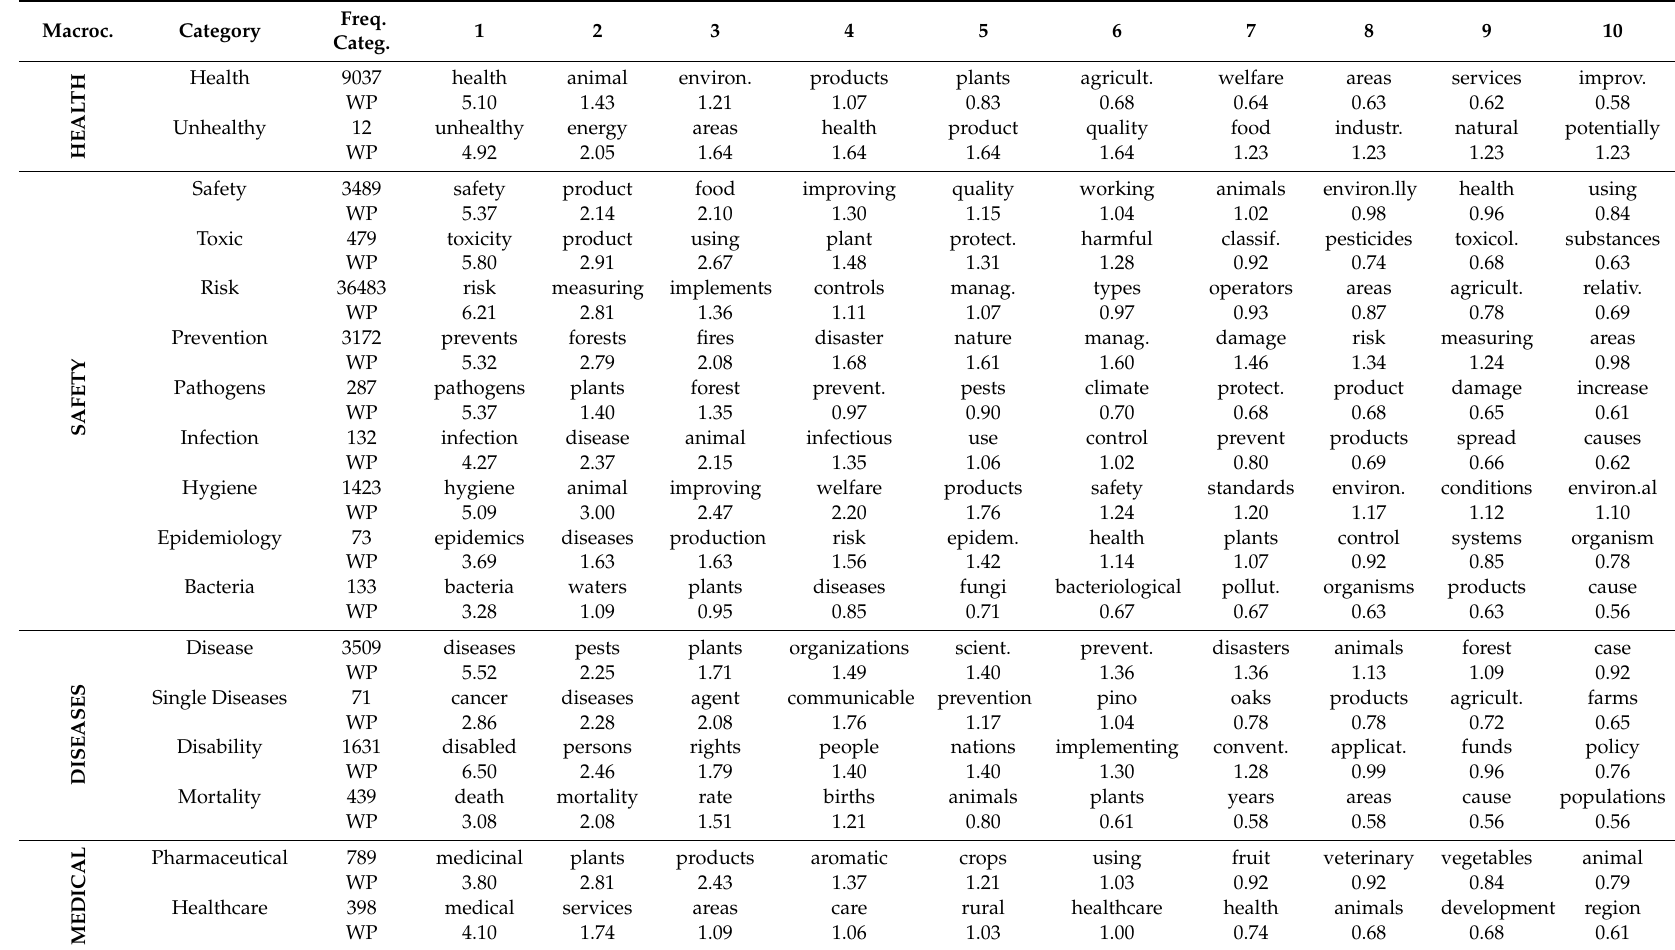
Table A5. Word frequency within single Health dimension